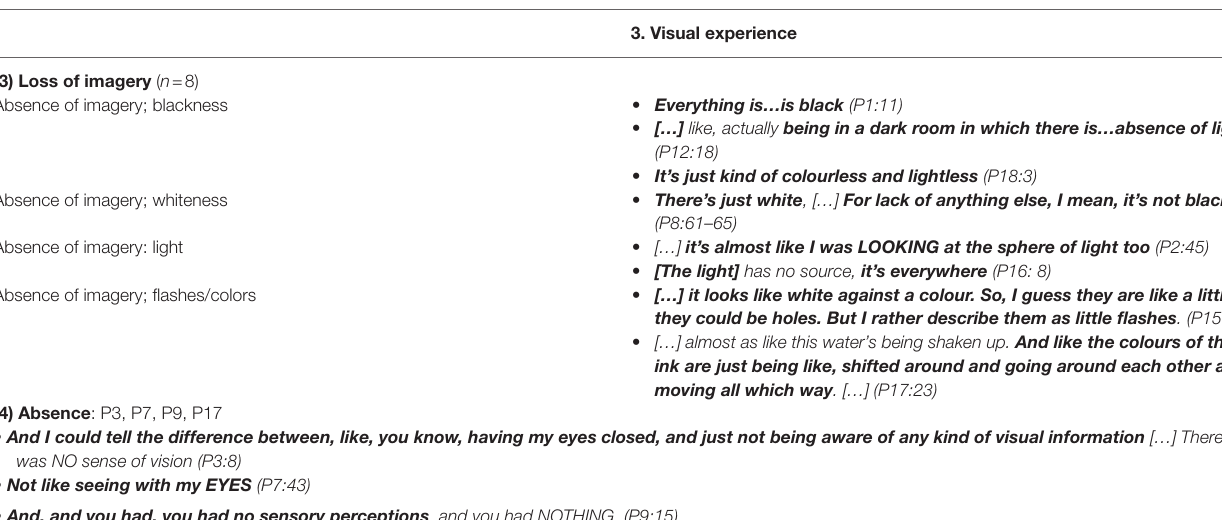
TABLE 8 | Illustrative descriptions for the category “ Visual experience ” and the sub-categories isolated during the “nothingness